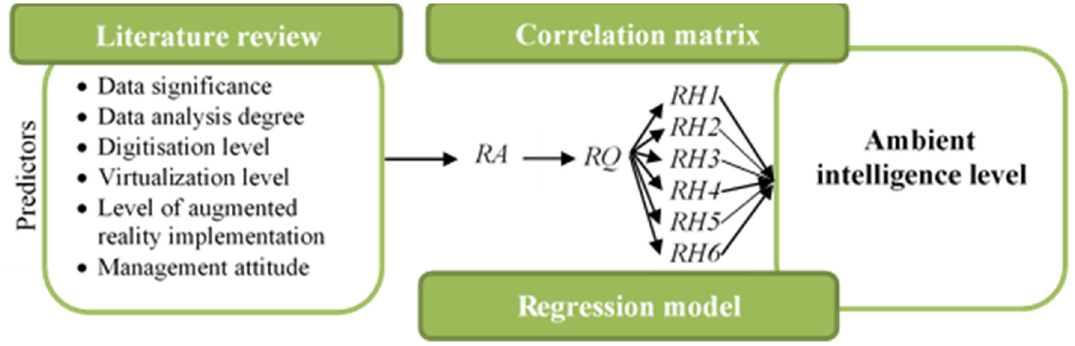
Figure 1. Research